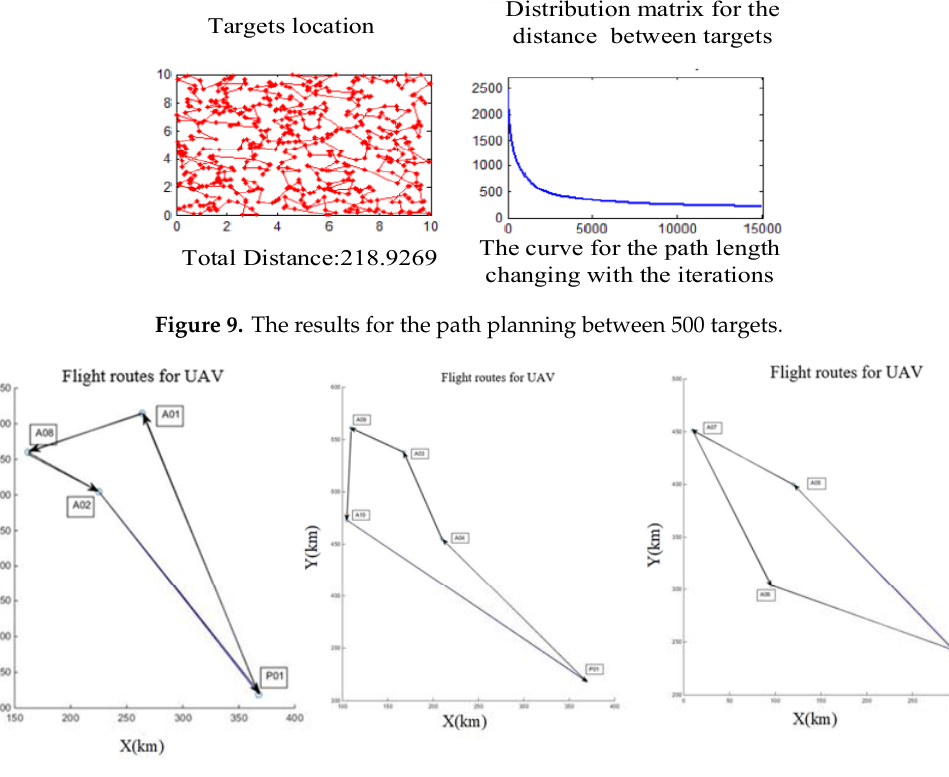
Figure 11. Local path planning for multi ‐ UAVs in the C target group.